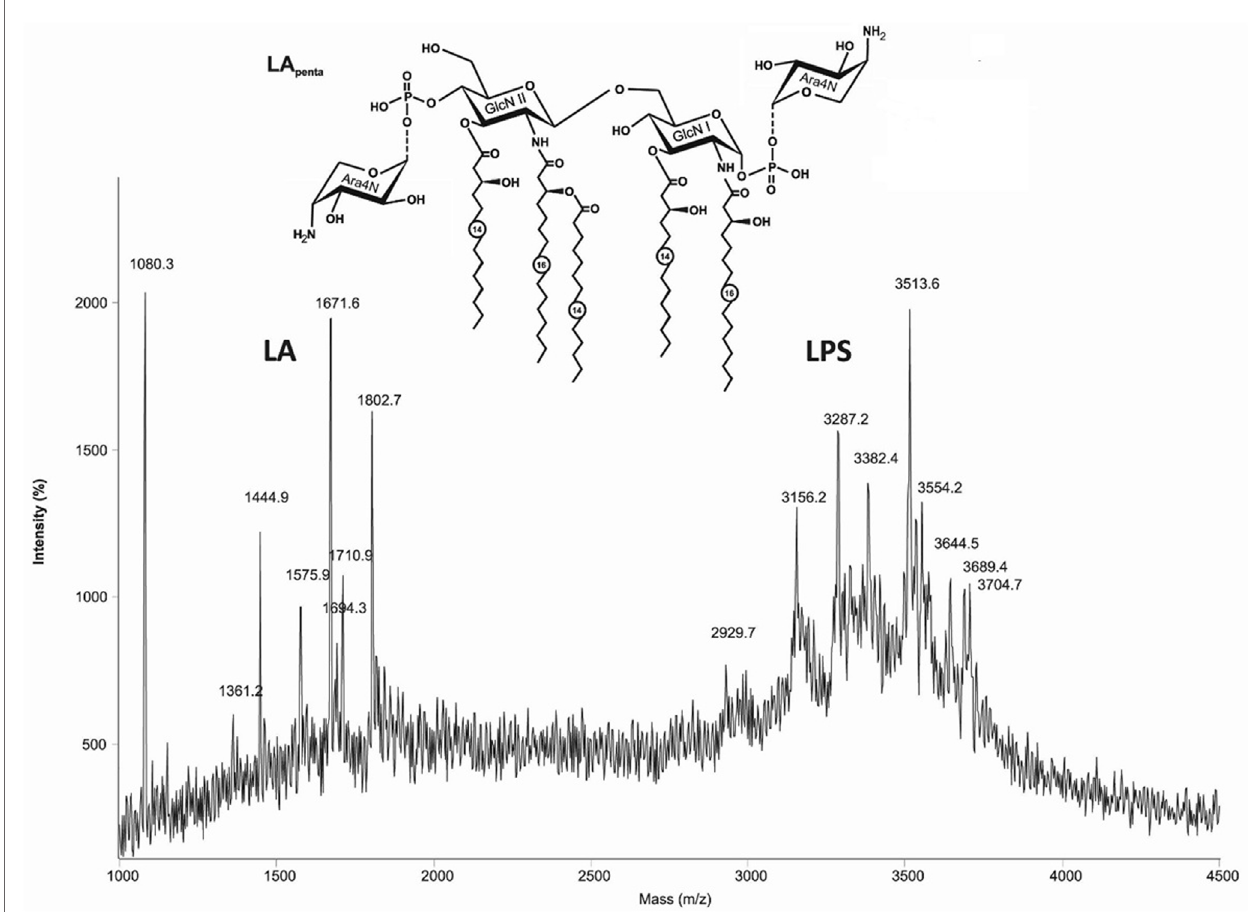
FigUre 2 | The MalDi-TOF mass spectrum of the lPs from Burkholderia mallei c-5 contained two clusters of ions, corresponding to lipid a fragments and intact lPs molecules . Structure of the pentaacyl lipid A in LPS from B. mallei. Ara4N, 4-amino-4-deoxyarabinose; GlcN, glucosamine. Numbers indicate the number of carbon atoms in the acyl chain. Dotted lines indicate non-stoichiometric